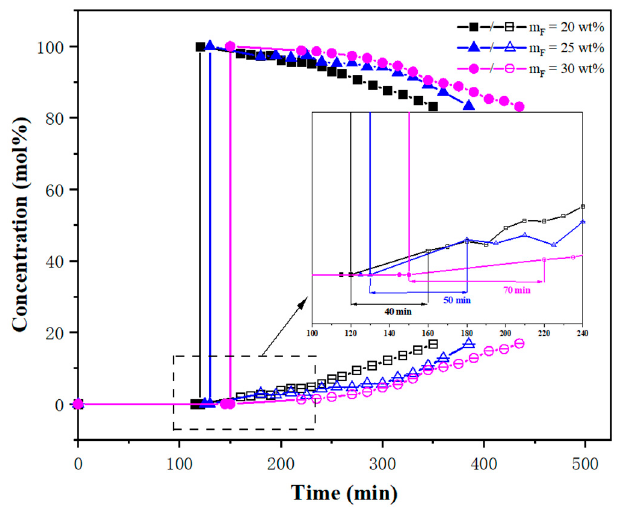
Figure 6. Breakthrough experimental results of the CH 4 /H 2 (34.22/65.78 mol%) mixture in the slurry with different solid contents of 20 wt%, 25 wt%, and 30 wt%, at 273.15 K, 2.00 MPa, and an inlet gas flow rate of 27.72 mL/min. (The solid curve in the figure is H 2 and the hollow curve is CH 4 ).